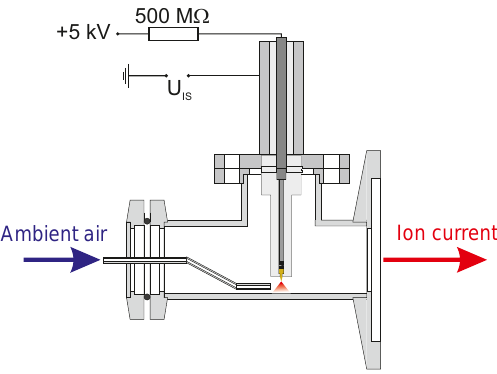
Figure 5. Gas-discharge ion source of AIMS-H 2 O: ambient air is guided to the discharge zone between a gold needle and the wall of the source (red shaded region). The needle has a positive potential of + 5kV relative to the shielding of the assembly which itself can be set at variable potential vs. ground. A resistance of 500M (cid:127) is integrated in order to limit the maximum ion current to